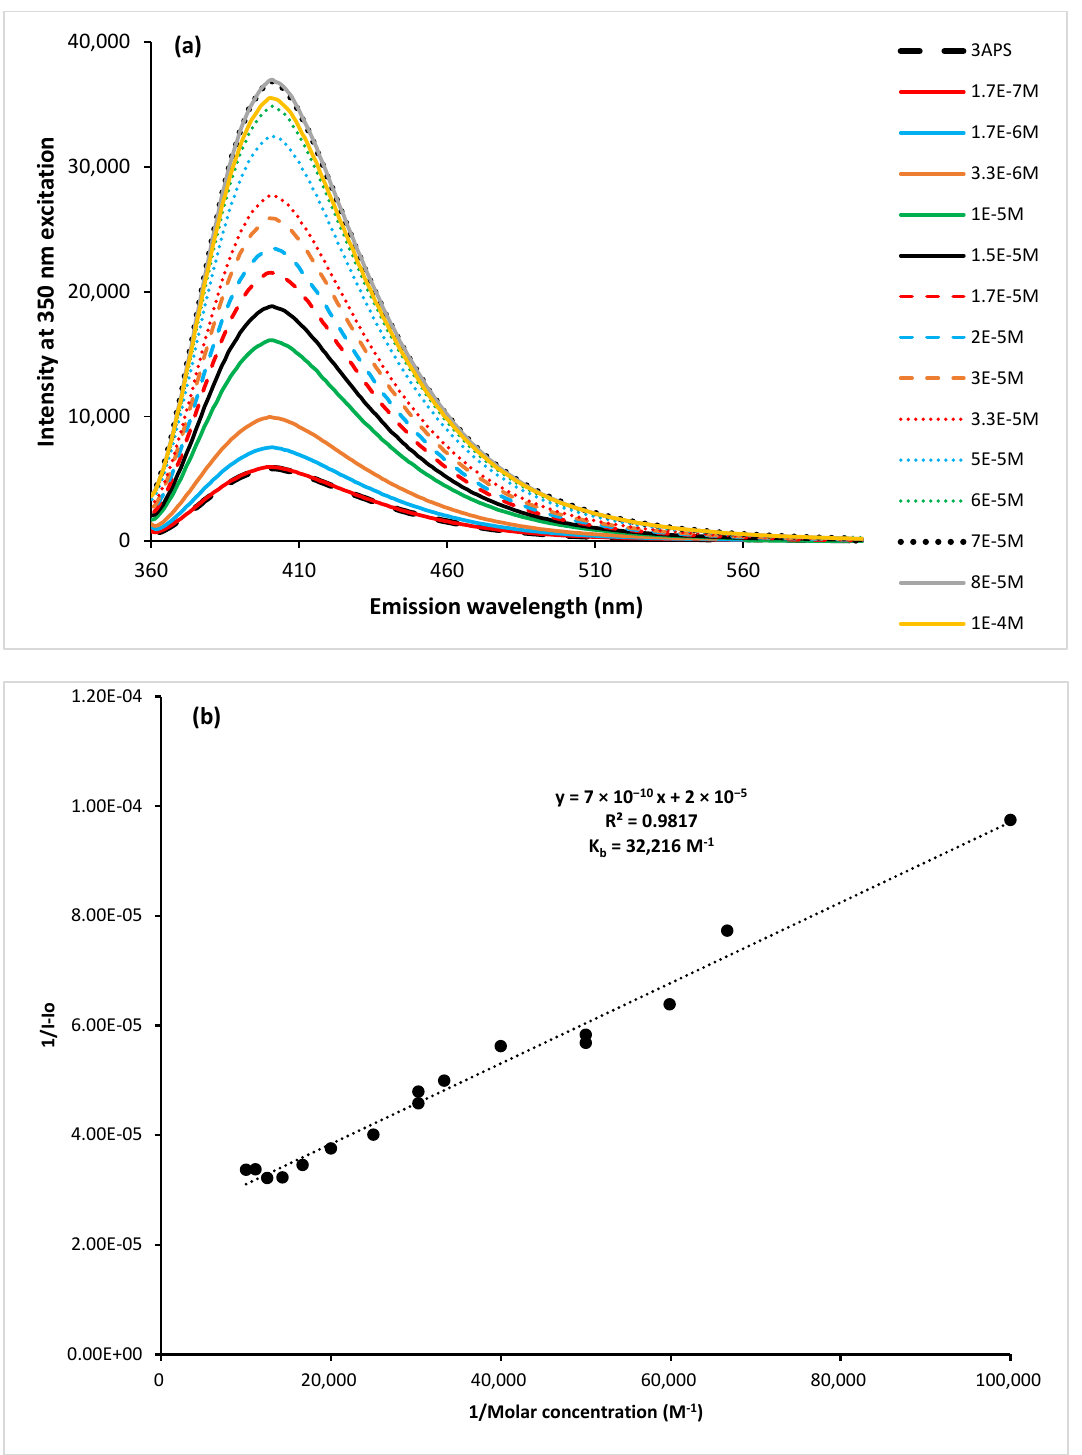
Figure 8. Emission of 3APS (2 × 10 − 6 M) upon titration with varying concentrations of Al(III) (1.7 × 10 − 7 – 1.0 × 10 − 4 M) at an excitation wavelength of 350 nm ( a ). In the Benesi – Hildebrand plot, I 0 is the emission intensity of 3APS alone, and I is the intensity upon adding varying concentrations of Al(III) in H 2 O – ACN (9:1). Both I and I 0 were recorded at 405 nm ( b ).